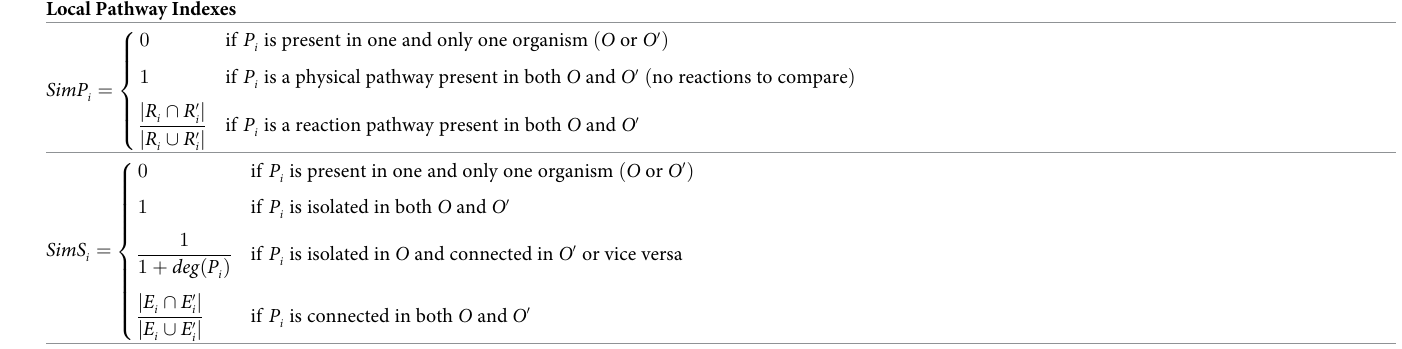
Table 2. Summary of local similarity